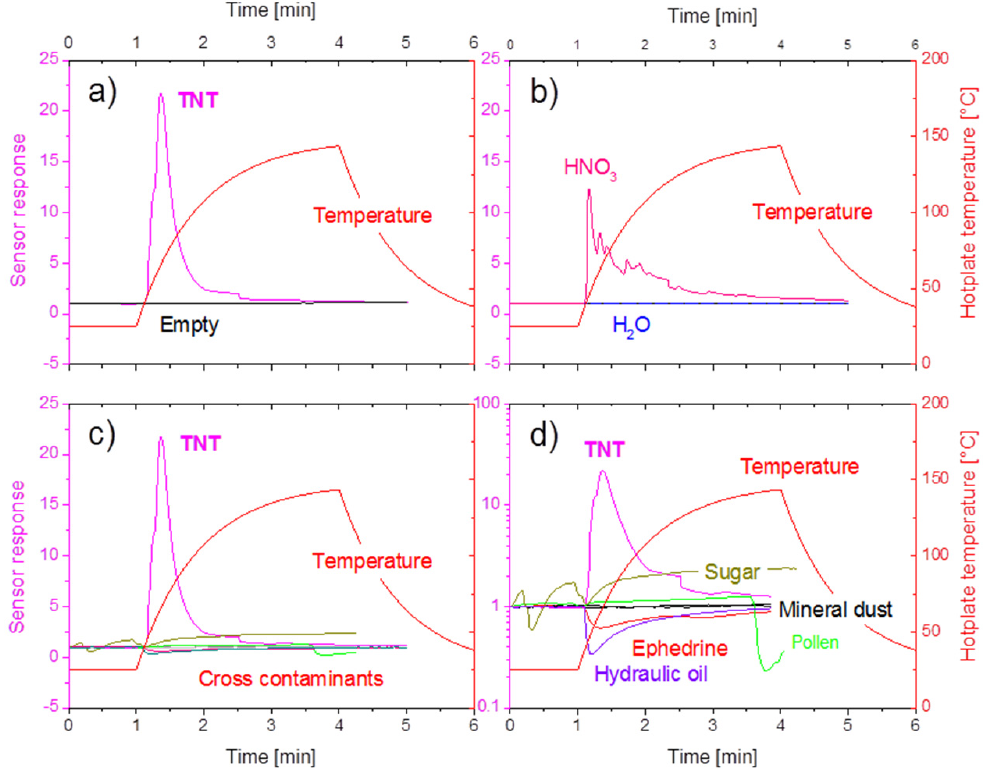
Figure 11. ( a ) Response of a single NO 2 MOX sensor to an empty (black) and a TNT-loaded hotplate (magenta) when the hotplate temperature (red) is ramped up; ( b ) control experiment in which pure water (blue) and nitrous acid (HNO 3 ) are evaporated; ( c ) control experiment in which many kinds of background particle (liquid) residue were evaporated; ( d ) same data as in ( c ), but plotted on a logarithmic scale.